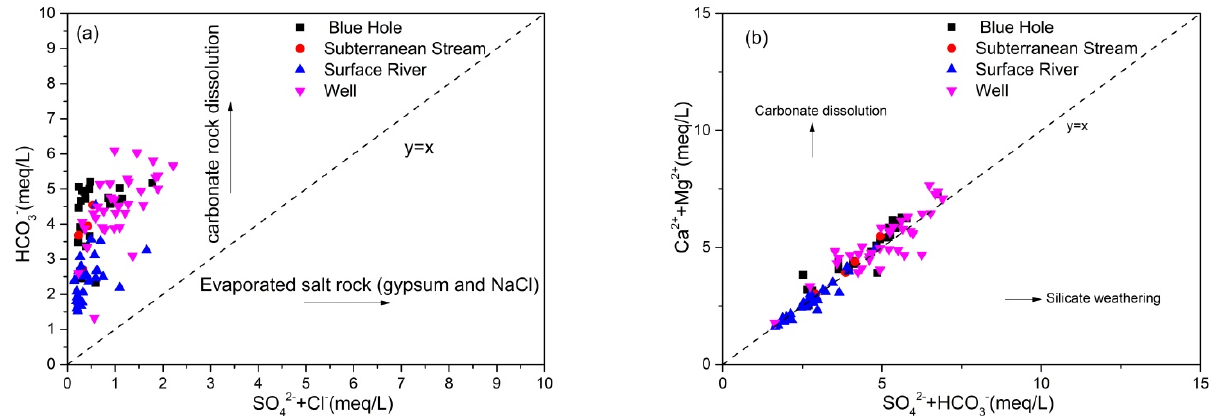
Figure 7. Relationships between major ions in the water of the Huixian karst wetland. ( a ) SO 42 − + Cl − vs HCO 3 − , ( b ) SO 42 − + HCO 3 − vs Ca 2+ + Mg 2+.